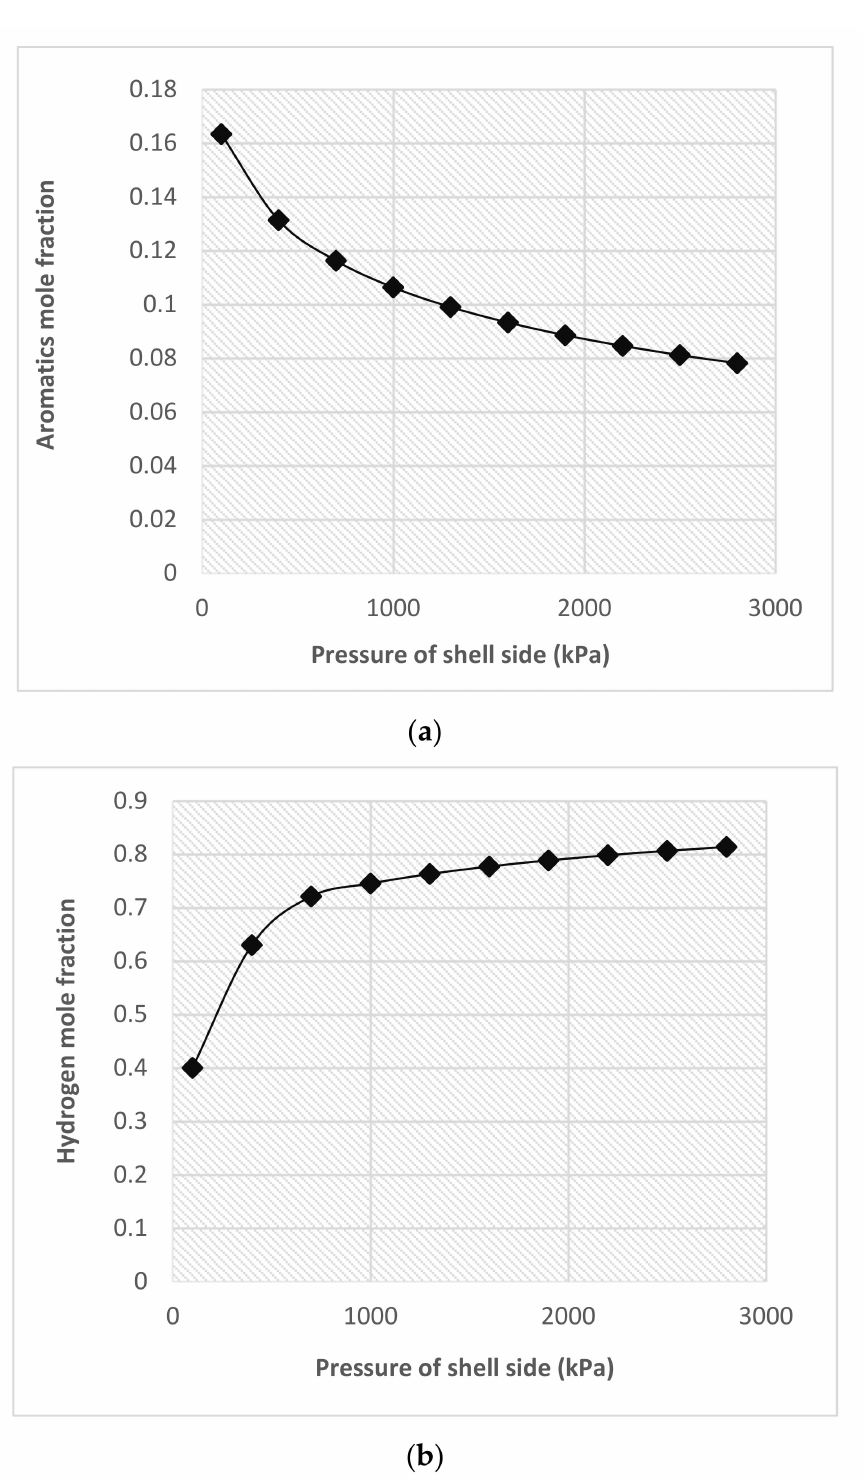
Figure 9. ( a ) Mole fraction of aromatic; and ( b ) mole fraction of outlet hydrogen in the reaction side as a function of shell side